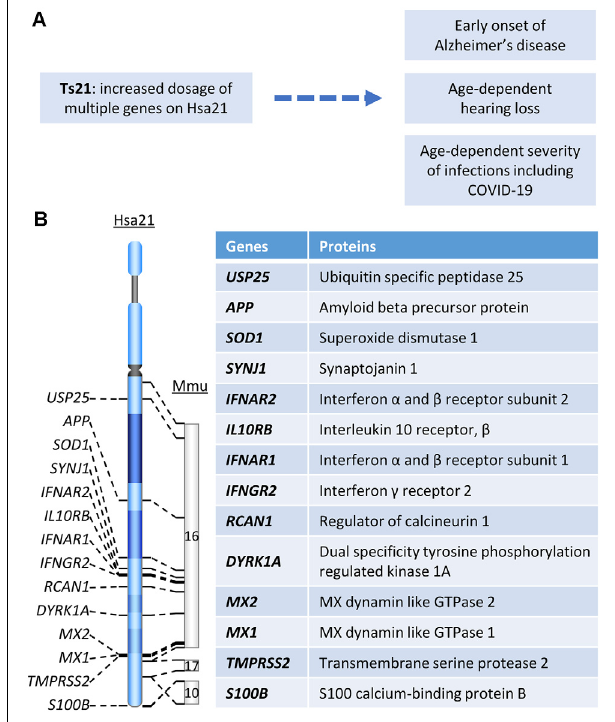
are products of Amyloid Precursor Protein (APP) processing ( Figure 1B , see below; Chen and Mobley, 2019a; Lott